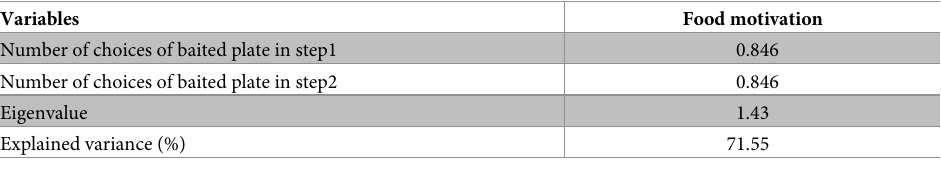
Table 6. Component derived from PCA on the variables measured in the food choice subtest.